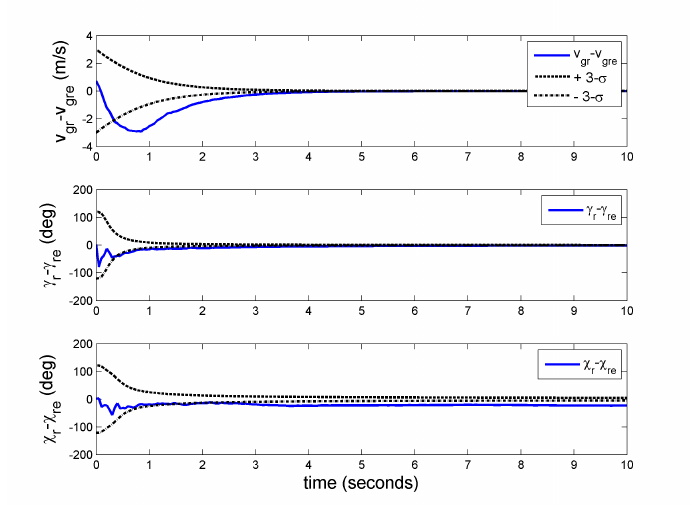
Figure 8. Speed, flight path angle and heading angle errors (true-estimated) with 3 − σ bounds for target UAV (Case